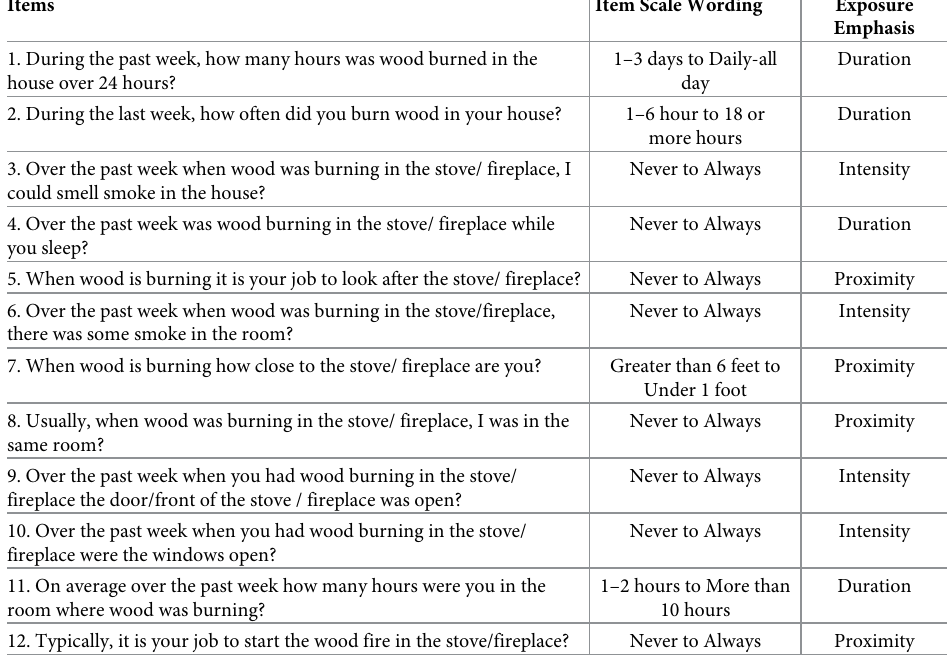
Table 1. Index of exposure to household air wood smoke questions, item scale wording and potential exposure emphasis.